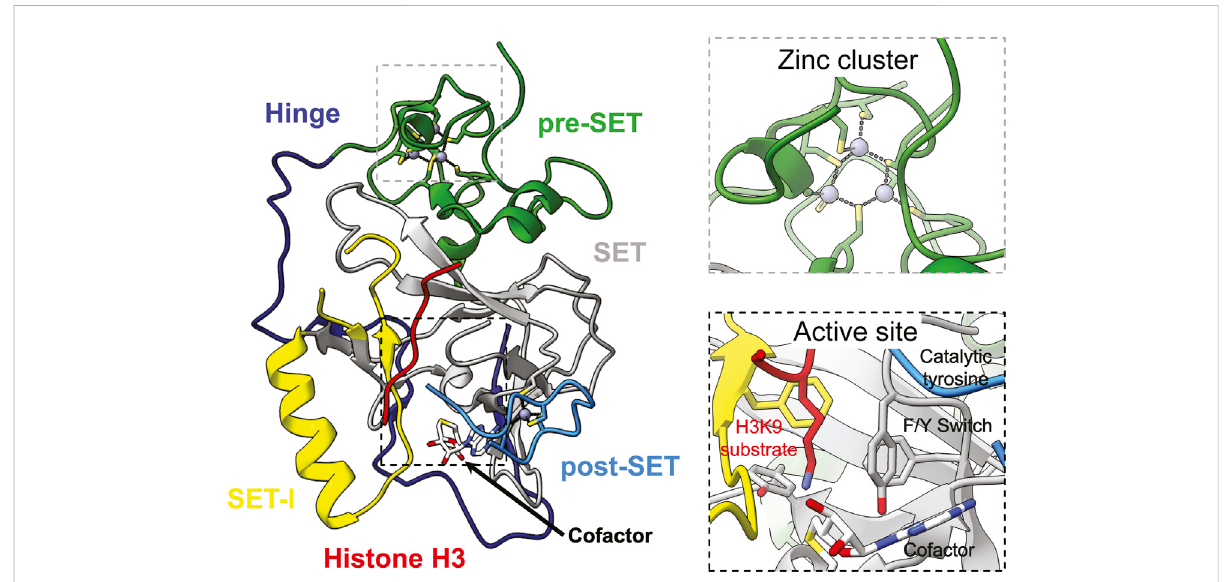
FIGURE 1 StructureoftheconservedcorecatalyticSETdomainofH3K9methyltransferases.Structureofthe fi rstSETdomaintobedetermined,Dim-5an H3K9 methyltransferase from Neurospora crassa , in complex with cofactor (white) and histone peptide substrate (red) (PDB ID 1PEG) (left). Close up of conserved cysteines and triangular zinc cluster of the pre-SET domain (top right). Close up of active site (bottom right). The Hinge, pre-SET, SET, SET-I, and post-SET domains are coloured dark blue, green, grey, yellow, and light blue, respectively. Zinc atoms are depicted as dark grey